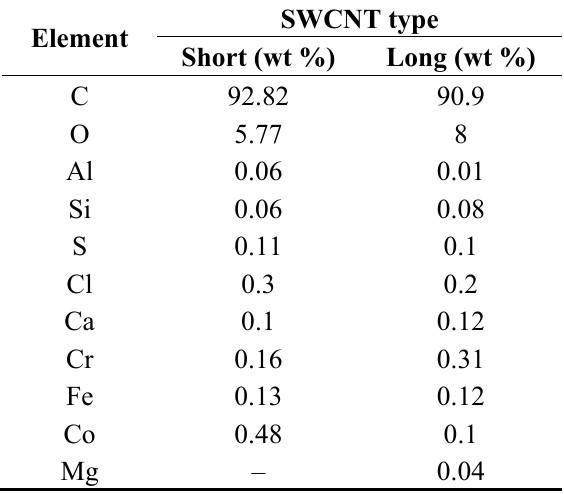
Table 2. Physicochemical Characterization of SWCNTs. Elemental distribution measured via